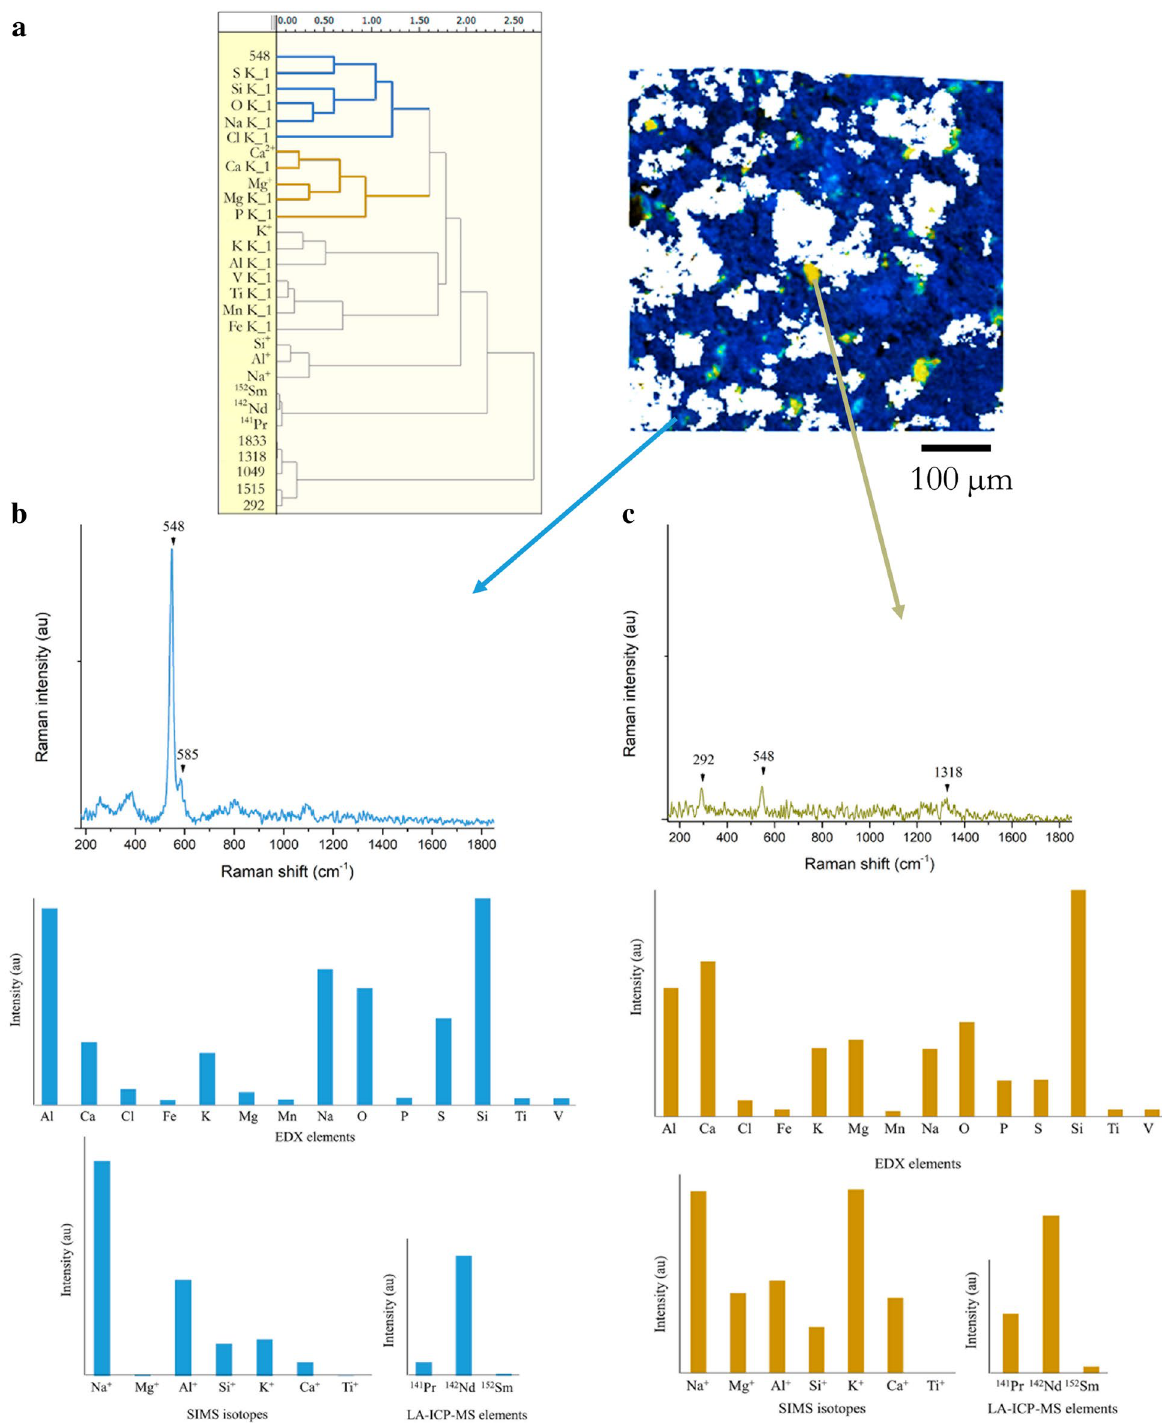
Figure 6. ( a ) Dendrogram of the loadings of the first five principal components of NU-1 sample PCA model, and SEM image superposed with the spatial distribution of the two sub-clusters marked in blue and dark yellow. Representative Raman spectra, EDX, SIMS, and LA-ICP-MS of blue ( b ) and dark yellow ( c )